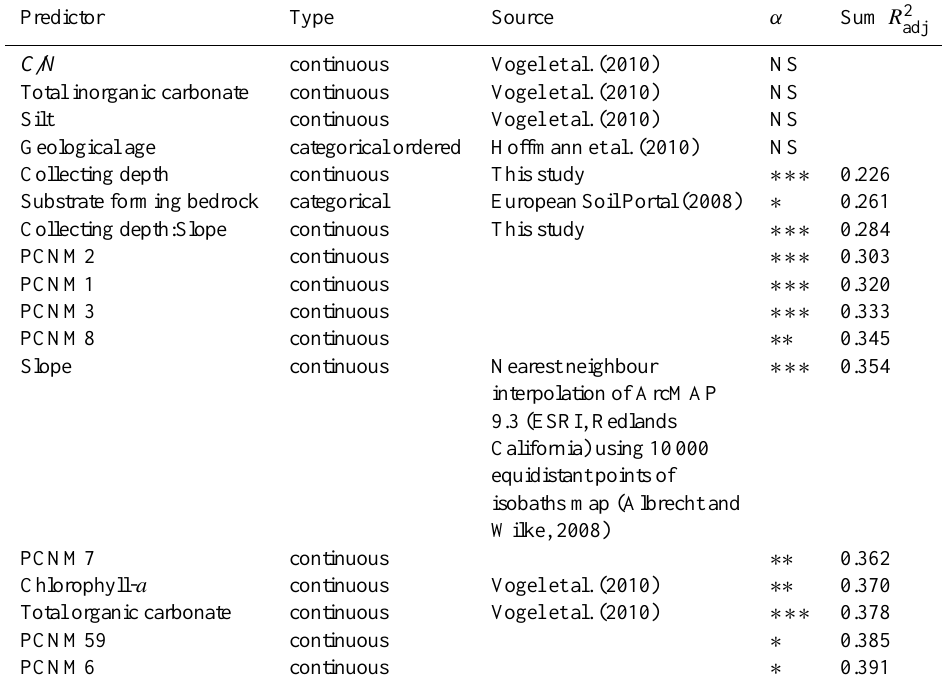
Table 1. Environmental and spatial predictors explaining the variance of 156 gastropod communities of Lake Ohrid. All environmental predictors were arcsin- or z-standardised and chosen by stepwise selection using a Bray-Curtis distance based redundancy analysis. Note that adding predictors to our model was always carried out with p < 0 . 05 and only the significance level for dropping the predictor is